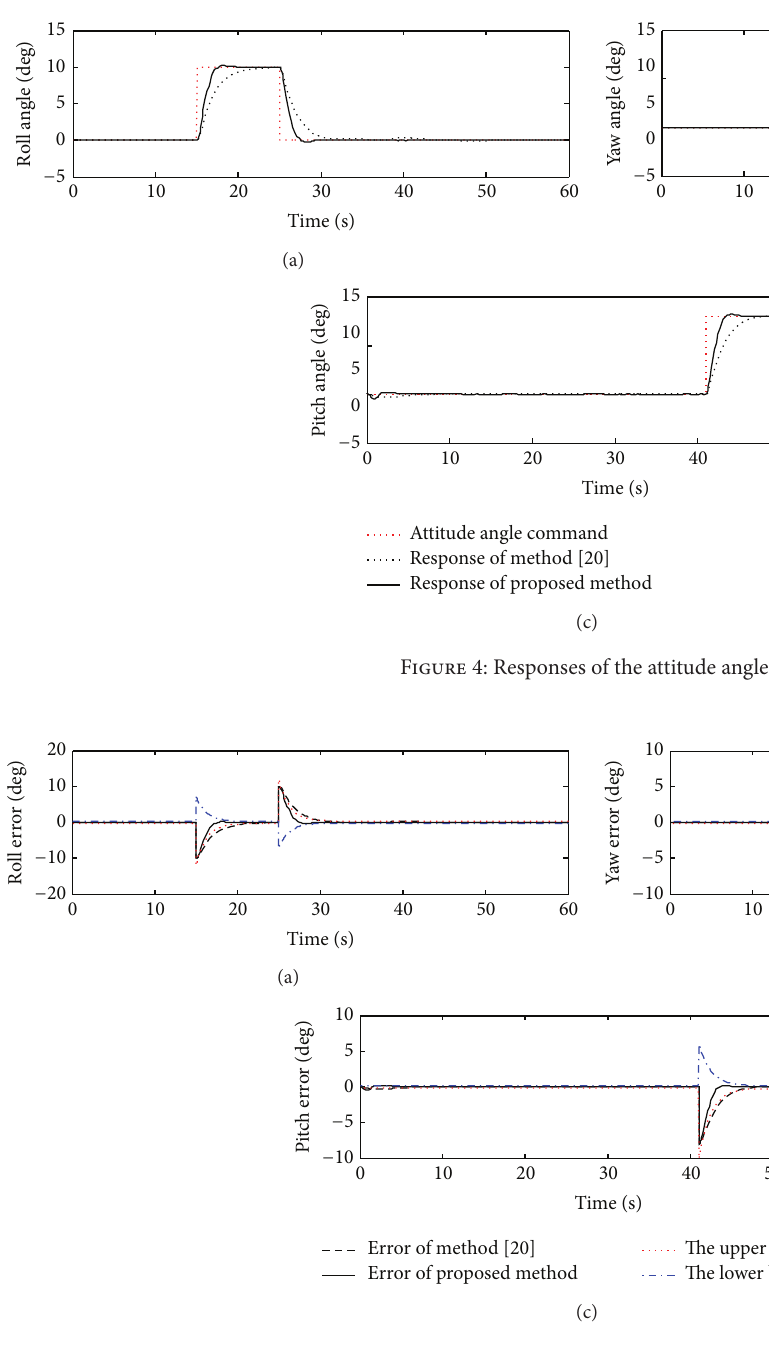
Figure 5: Tracking errors of the attitude